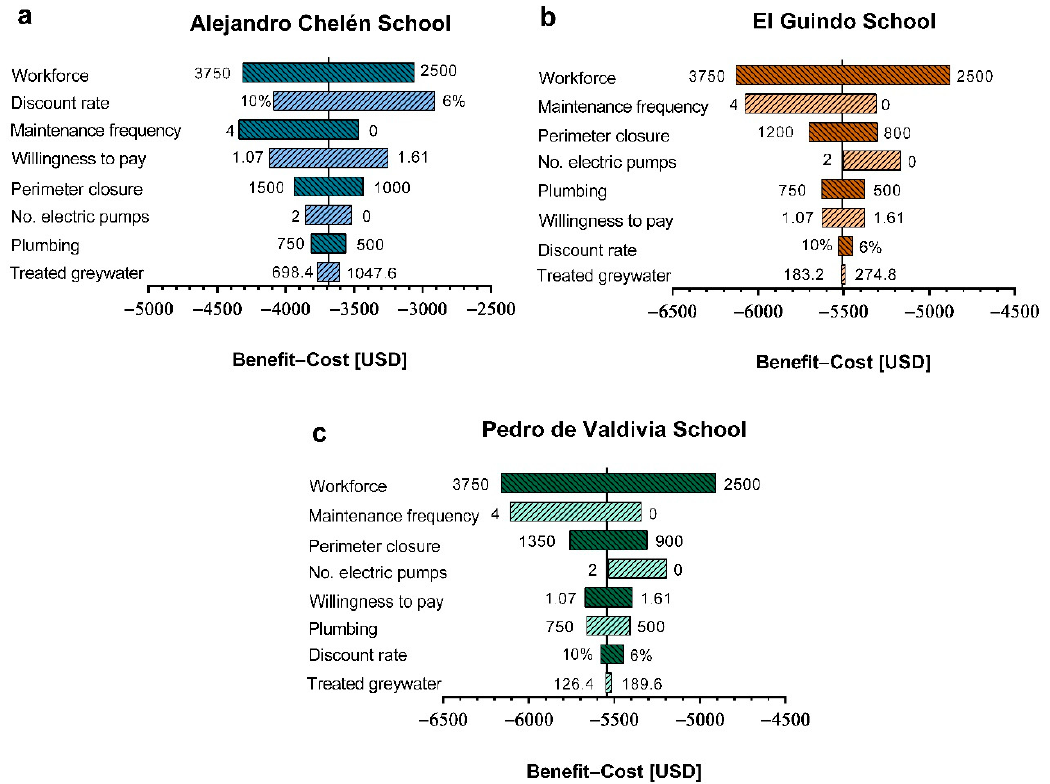
Figure 2. Sensitivity analysis of the variation of workforce costs, maintenance frequency, costs of perimeter closure, number of electric pumps, plumbing costs, greywater treated daily, discount rate, and willingness to pay for green areas at ( a ) Alejandro Chelén School; ( b ) El Guindo School; and ( c ) Pedro de Valdivia School .